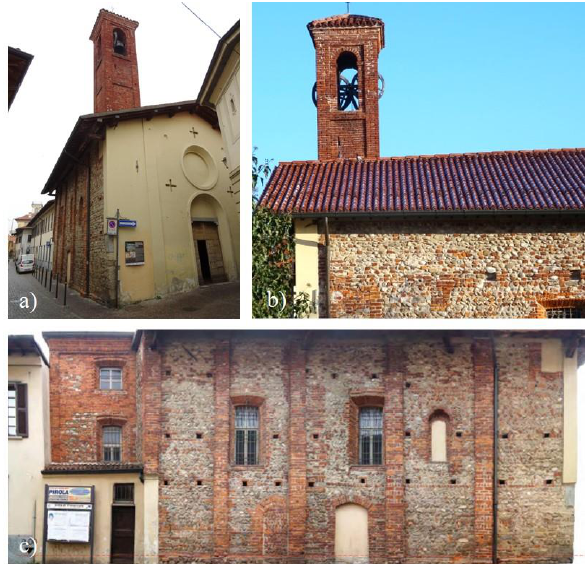
Figure 2. St. Antonio Oratory: a) the façade; b) the bell tower and c) the rectified north side with its stratifications.